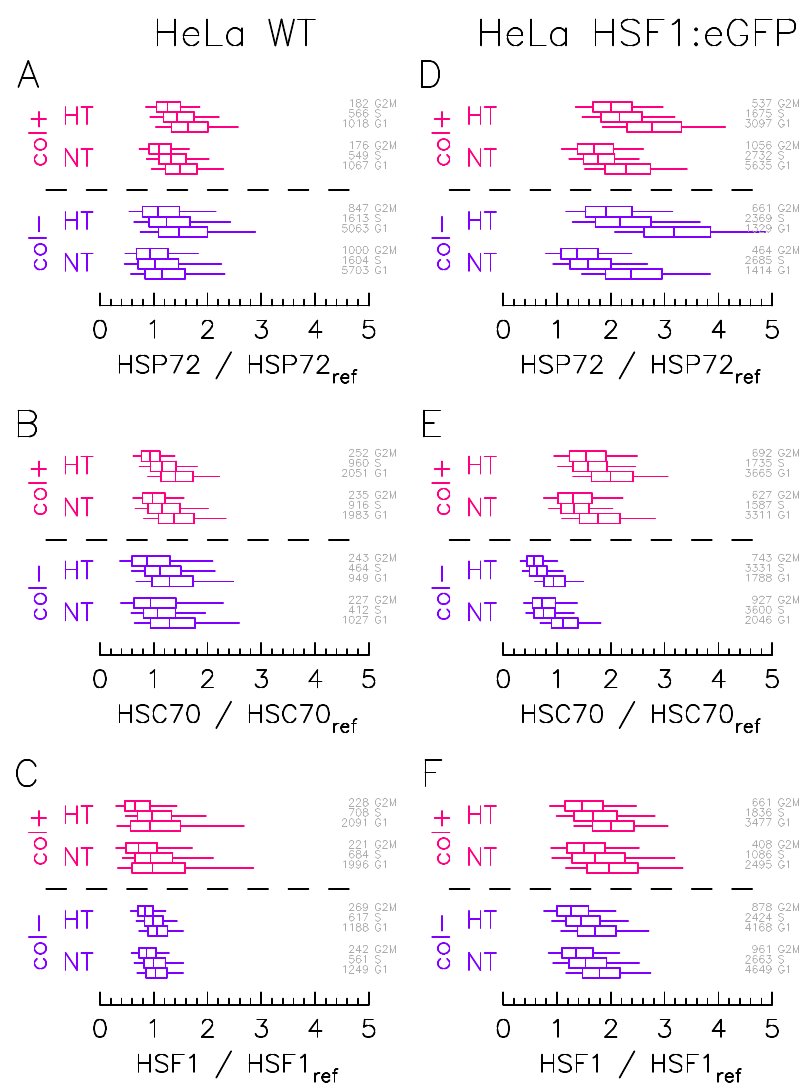
Figure 2. Culture condition affects the protein expression level distributions more than cell cycle phase. HSP2, HSC70, and HSF1 protein expression distributions measured by immunofluorescence in ( A – C ) HeLa Wild Type and ( D – F ) HeLa–HSF1:eGFP cell lines for in case of NormoThermia (NT: 37 ◦ C) or HyperThermia (HT: 1 h at 43 ◦ C). The boxes represent quartile and the whiskers represent the 9th percentile and the 91st percentile. The color indicates the culture condition: blue for cells adhered to non-coated (col − ); red for cells adhered to collagen-coated (col+). Cell cycle analysis on Hoechst fluorescence signals is used to cluster cells by cell-cycle stage (G1, S, G2/M), cell number and cell-cycle stage are indicated in gray directly on the right left of each the box plot. The fluorescence level is normalized to the Hoechst fluorescence signal and the reference level (HSF1 ref , HSP72 ref , or HSC70 ref ) corresponds to the median renormalized fluorescent value measured on HeLa WT cell line in G1 phase at 37 ◦ C for cells adhered to